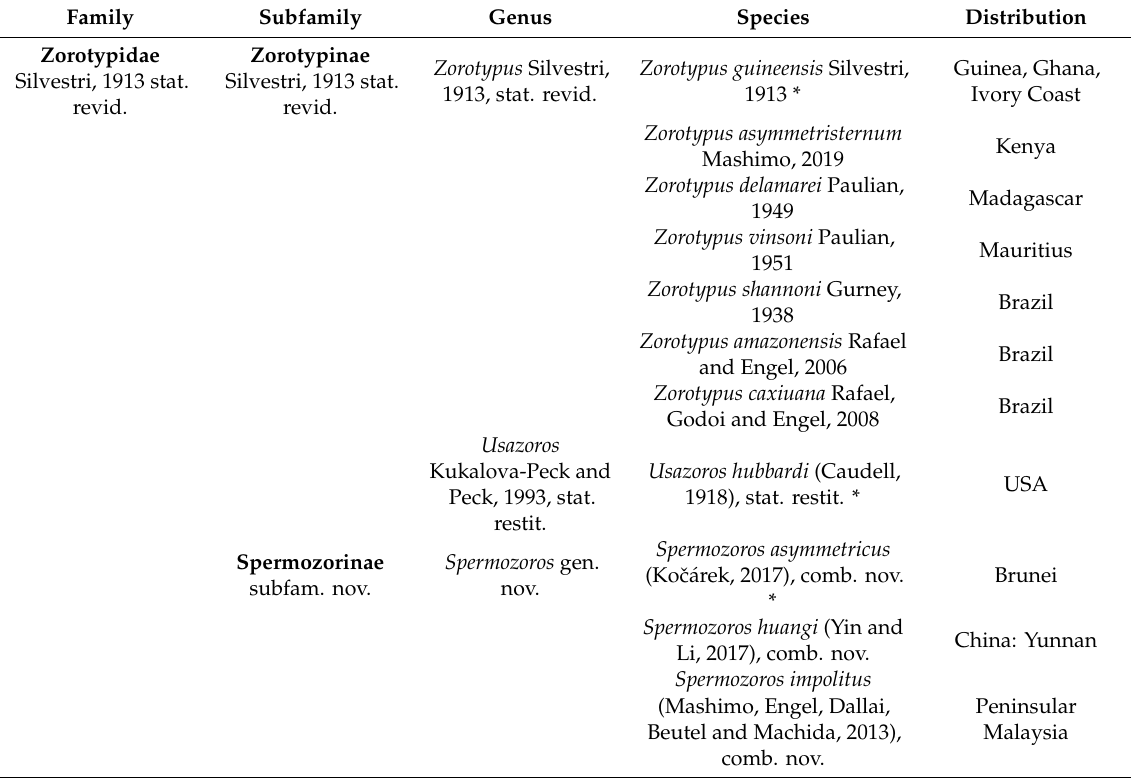
Table 2. Summary of updated suprageneric classification of